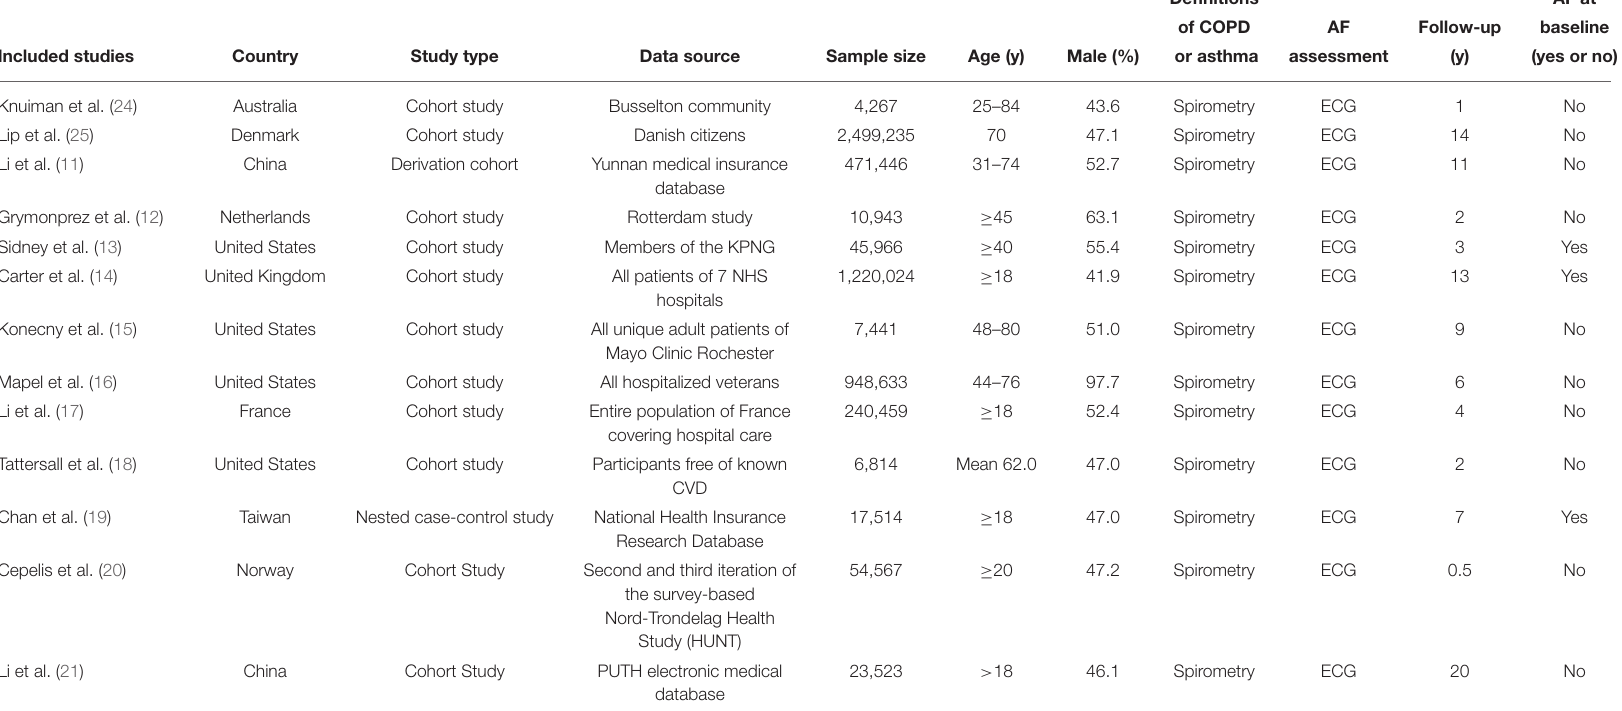
TABLE 1 | Baseline characteristics of the included